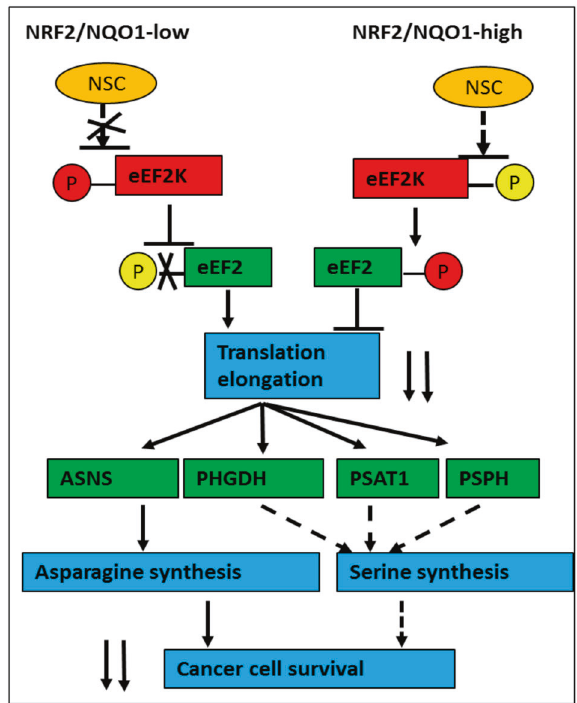
Fig. 6 Proposed model of selective anticancer activity of NSLC01 in cancer cells with high NRF2 activation. NSLC01 selectively activates eEF2K by inhibiting its phosphorylation at S366; activated eEF2K then phosphorylates the downstream eEF2 at T56, inhibiting its translation elongation function; this inhibition of translation reduces the availability of enzymes (ASNS, GHPDH, PSAT1, and PSPH) that drive the synthesis of asparagine and likely, serine as well necessary for cancer cell survival and